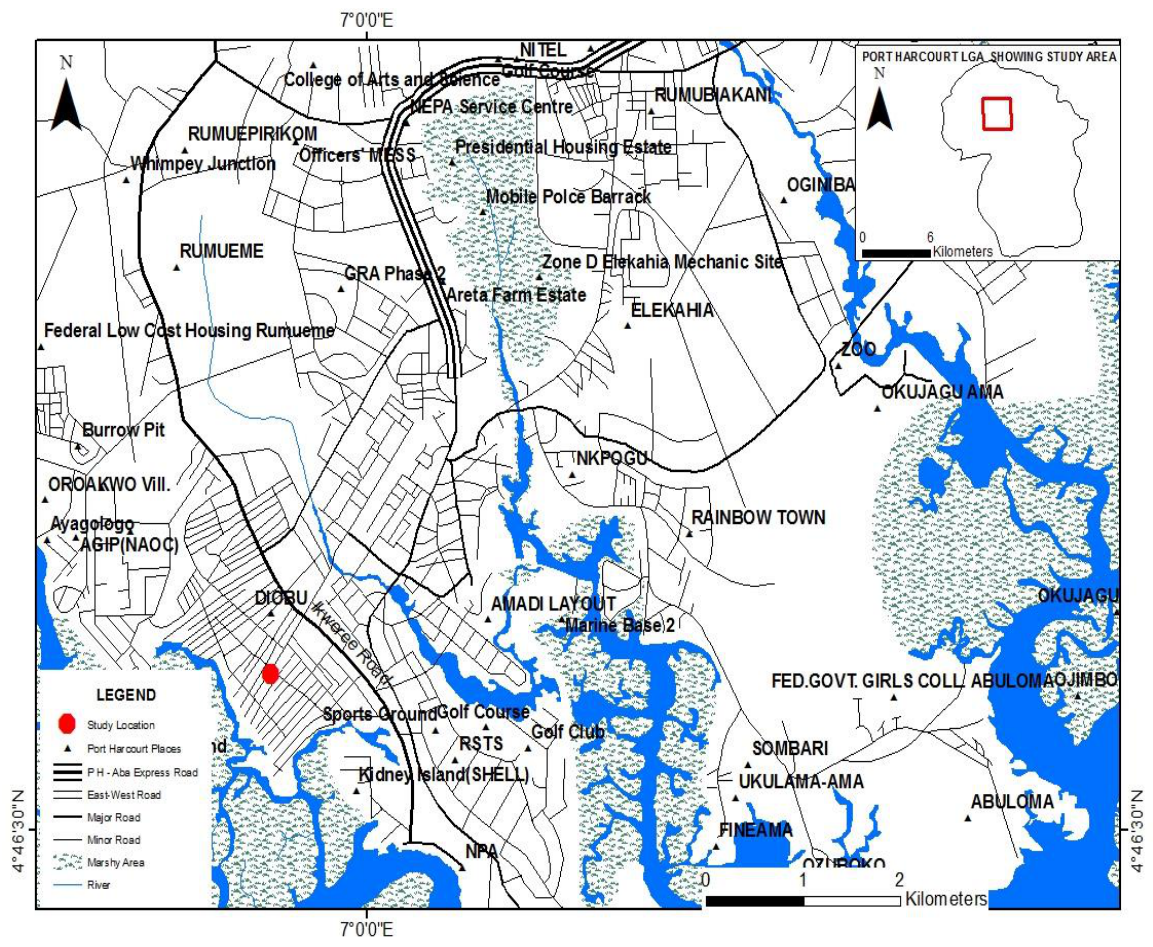
Figure 1. E-waste dumpsite Iloabuchi electronics market, Port Harcourt, Rivers State,